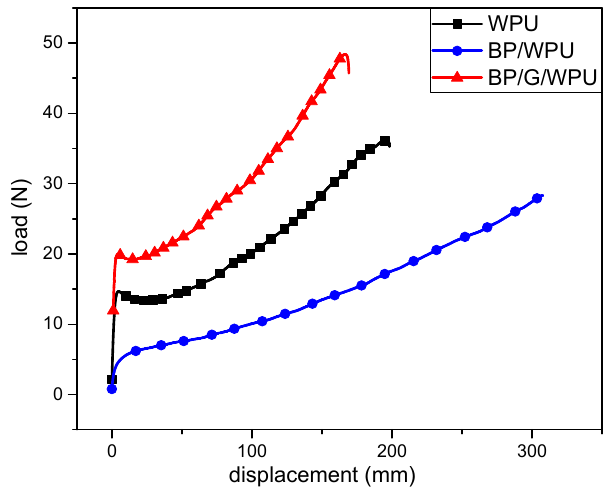
Figure 12. Load/displacement curves for the pure WPU, BP/WPU, G/WPU and BP/G/WPU.